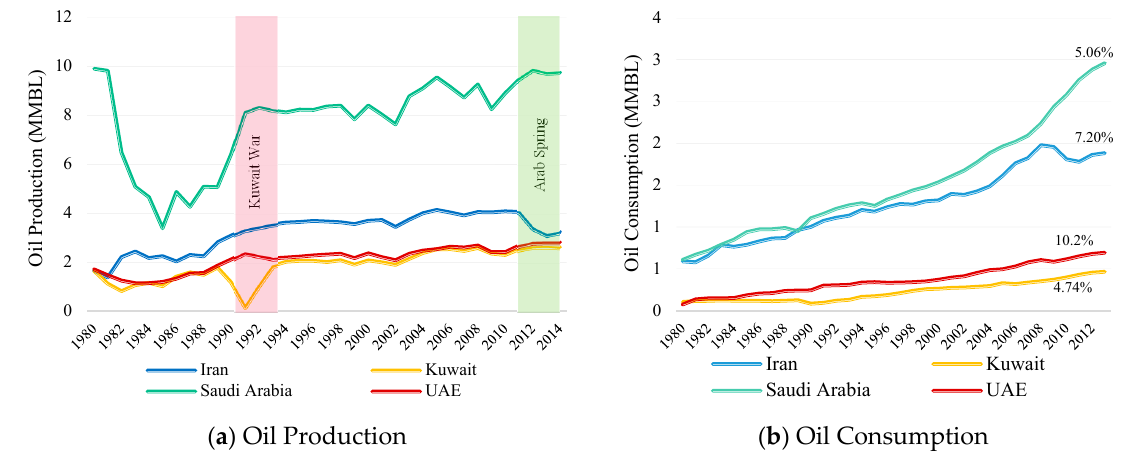
Figure 1. ( a ) Total oil production (1980–2014); ( b ) Total oil consumption (1986–2012). Percentages refer to the annual growth rate over the analysis period. Based on data from [1].